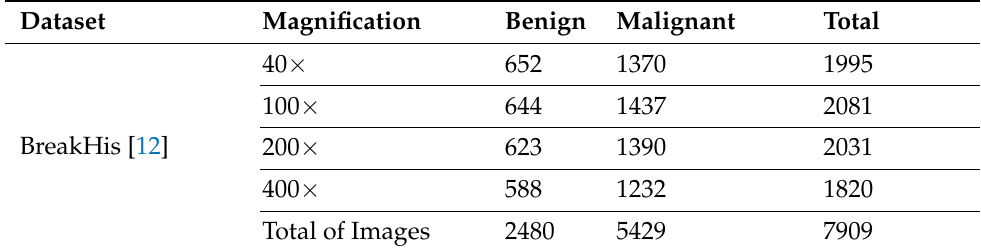
Table 1. A breakdown of the publicly available breast cancer classification BreakHis dataset. This dataset contains multiple image magnifications defined for benign and malignant